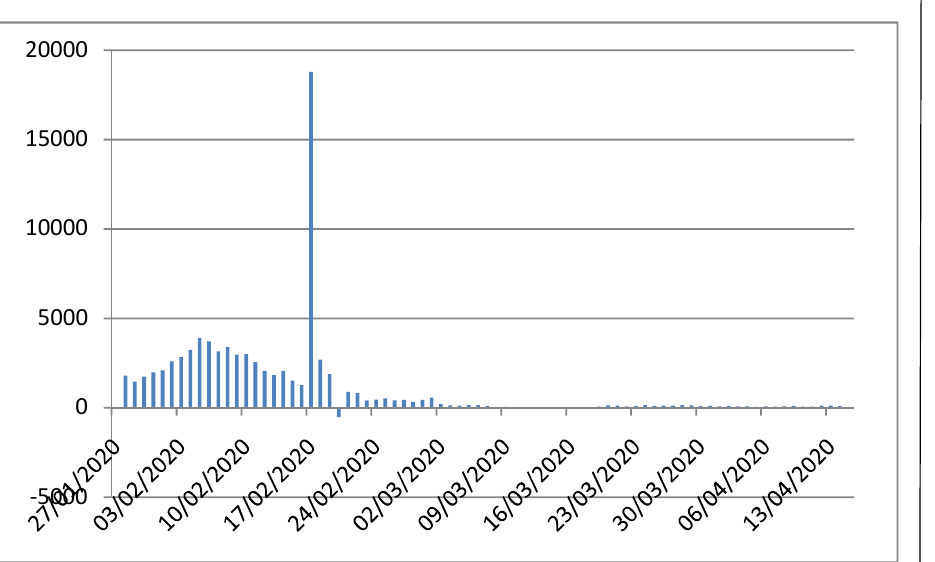
Figure 1 – Histogram of the infected people on a daily basis in China in January